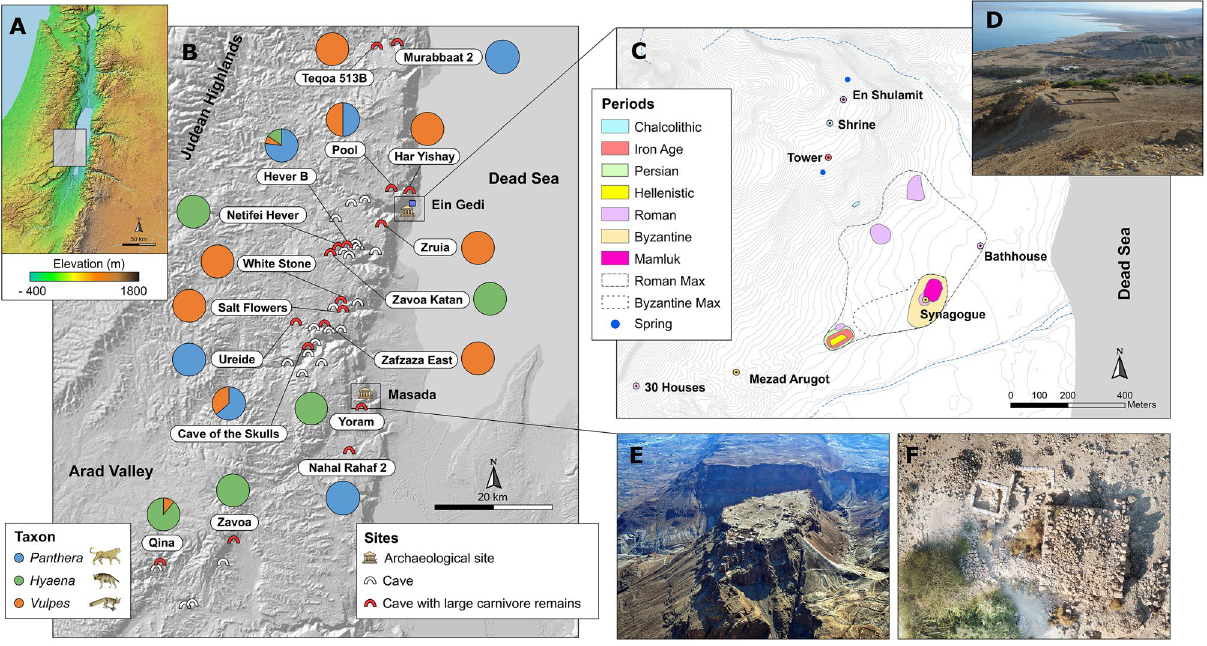
Figure 2. Map of the southern Judean Desert, showing caves and archaeological sites included in this study. ( A ) Elevation map of the Southern Levant. ( B ) Map of the study area showing caves surveyed (white arches) and caves where large carnivore remains were found and included in the statistical analyses (red arches). The pie charts show the relative proportion of leopard ( Panthera pardus , blue), hyena ( Hyaena hyaena , green), and fox ( Vulpes cana and V. rueppellii , orange) remains recovered from each cave. ( C ) Topographic map of the Ein Gedi oasis, with convex hulls drawn around the archaeological sites of different historical time periods to calculate the area of occupation. ( D ) View of the Ein Gedi Oasis from the Chalcolithic shrine above the Ein Gedi spring. ( E ) Aerial view of the archaeological remains of Masada. Photo by Abraham Graicer used with permission. ( F ) Aerial view of the Roman to early Byzantine Tower in Ein Gedi during the 2019 field surveys, with several archaeological test pits around the main structure. Photo by Tal Rogovski used with